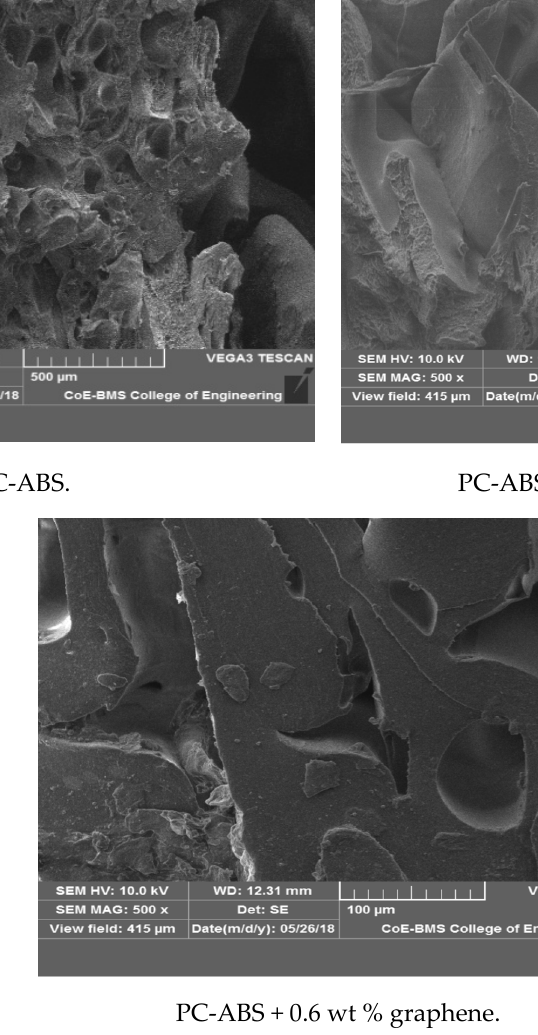
Figure 16. SEM of fractured tensile specimens of PC-ABS, PC-ABS+0.2 wt % graphene, and PC-ABS+0.6 wt % graphene. Table 2. Modulus, yield strength, and % elongation of PC-ABS and its composites.